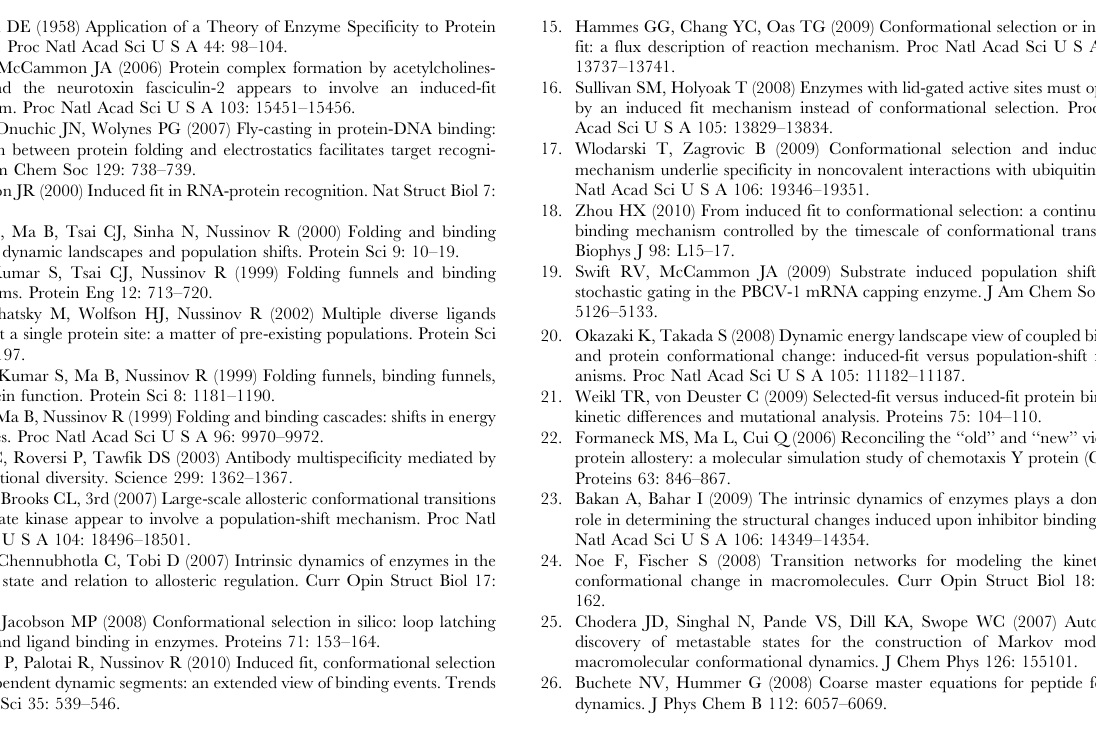
ligand heavy atoms when the ligand is strongly interacting with the protein. (TIF) Figure S8 Twenty slowest implied timescales as a function of lag time computed from (a) MSM containing 3730 microstates and (b) MSM containing 54 macrostates. Both plots level off at a lag time of , 4 ns. Thus we choose 6 ns to construct final MSMs. (TIF) Table S1 Averaged RMSD of the LAO protein Lobes I and II between three representative encounter complex conformations and the apo and bound X-ray structures. C a atoms of the Lobe I residues 6-88 & 195-227 or Lobe II residues 92-185 were included in the RMSD calculations. The structural alignment and RMSD calculation were performed separately for each Lobe. (PDF) Text S1 Structural features of the macrostates. (PDF) Text S2 Binding/unbinding transitions observed in the MD dataset. (PDF) Text S3 Implied timescales calculation.